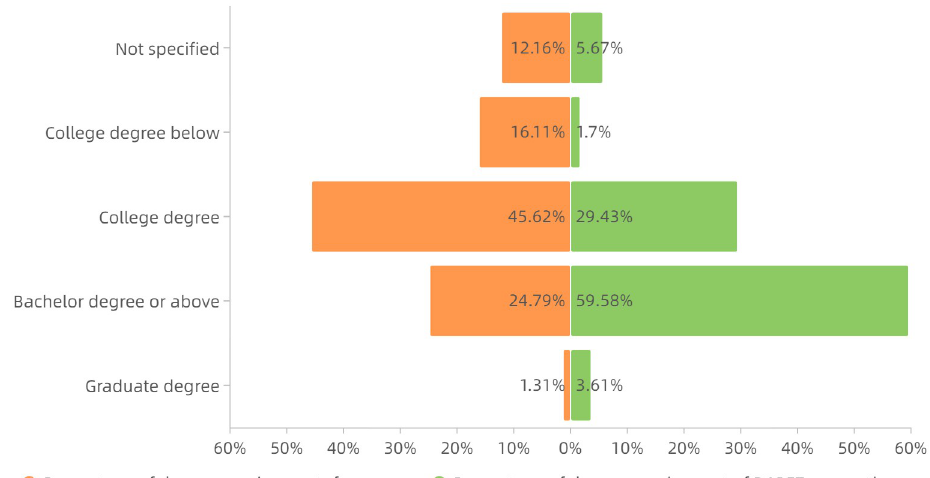
Fig 9. Comparison of distributions of degree requirement.